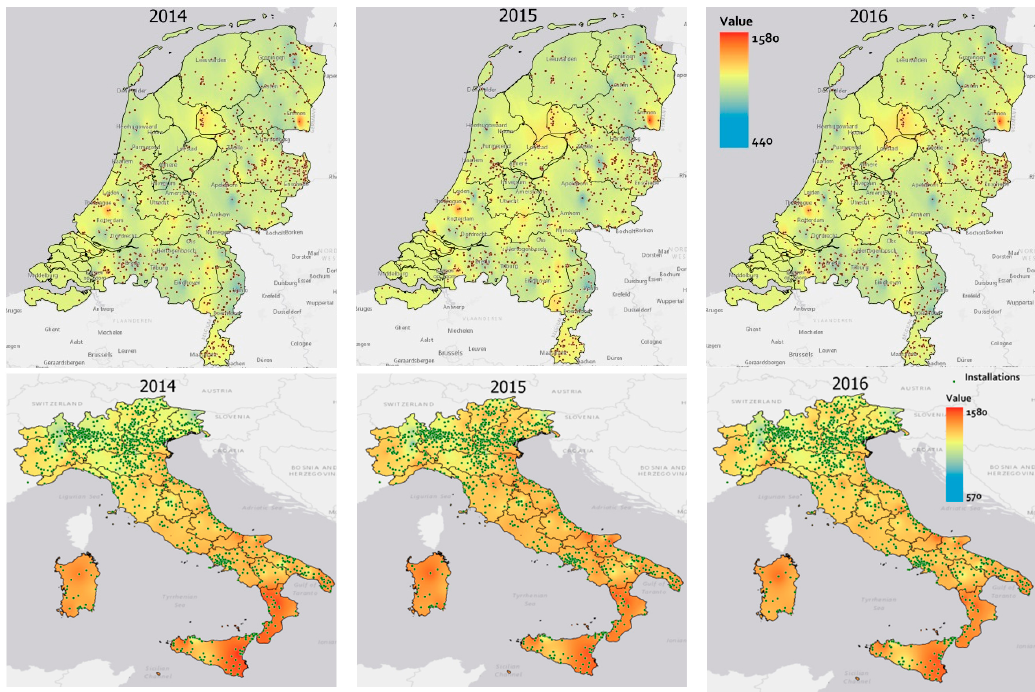
Figure 6. Annual specific yield variation from the installations (up to 20 kWp) in the Netherlands ( above ) and Italy ( below ) for the years 2014–2016, visualized using interpolation techniques.